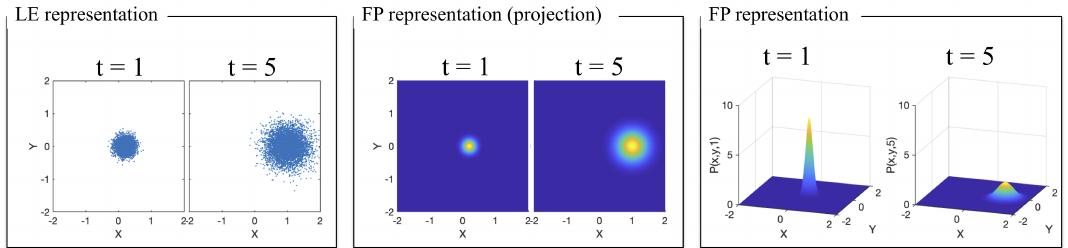
Figure 8. LE and FP solutions for two-dimensional Brownian motion with constant drift. For both representations, D = 10 − 2 µ m 2 /s, u = 0.2 µ /s and time is in seconds. For the LE representation, the total number of particles is 5 × 10 3